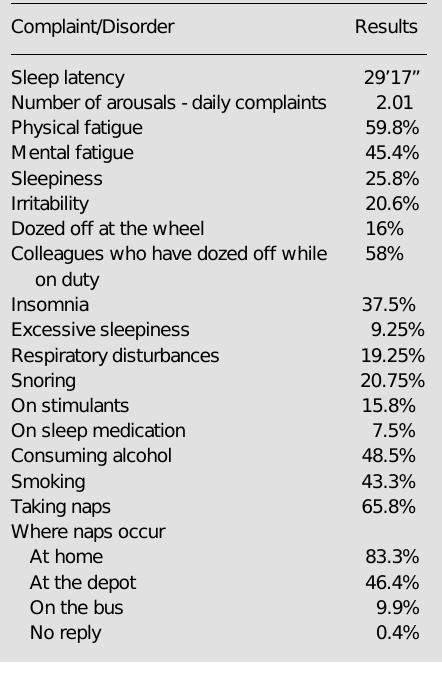
Table 4 - Data concerning sleep complaints, sleep pattern and use of psychotropic drugs (N = 400). Complaint/Disorder